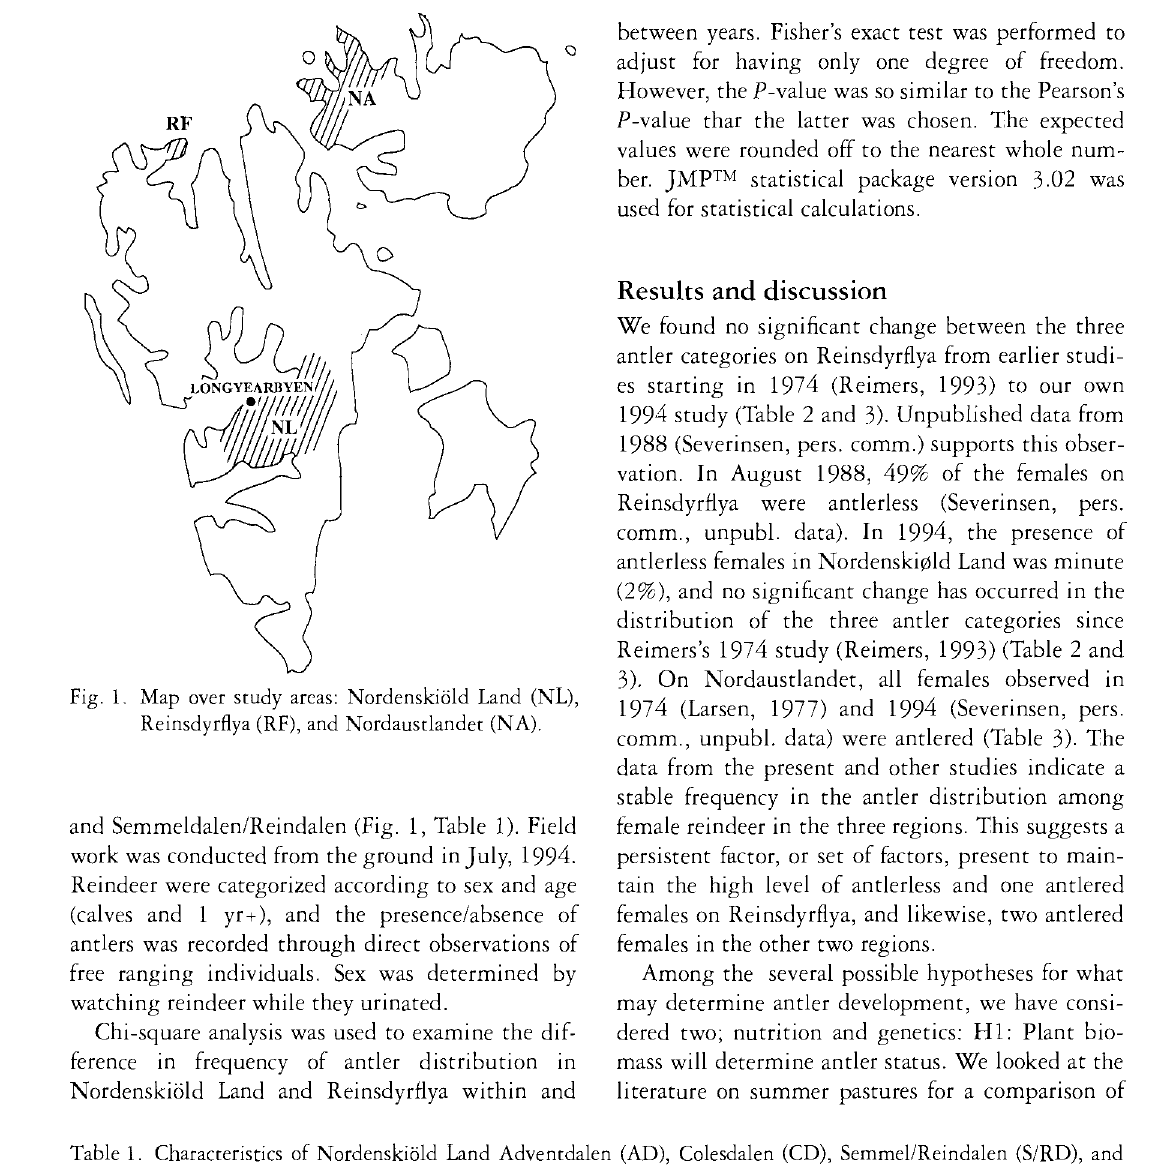
Table 1. Characteristics of Nordenskiold Land Adventdalen (AD), Colesdalen (CD), Semmel/Reindalen (S/RD), and Sassendalen (SD), Reinsdyrflya and